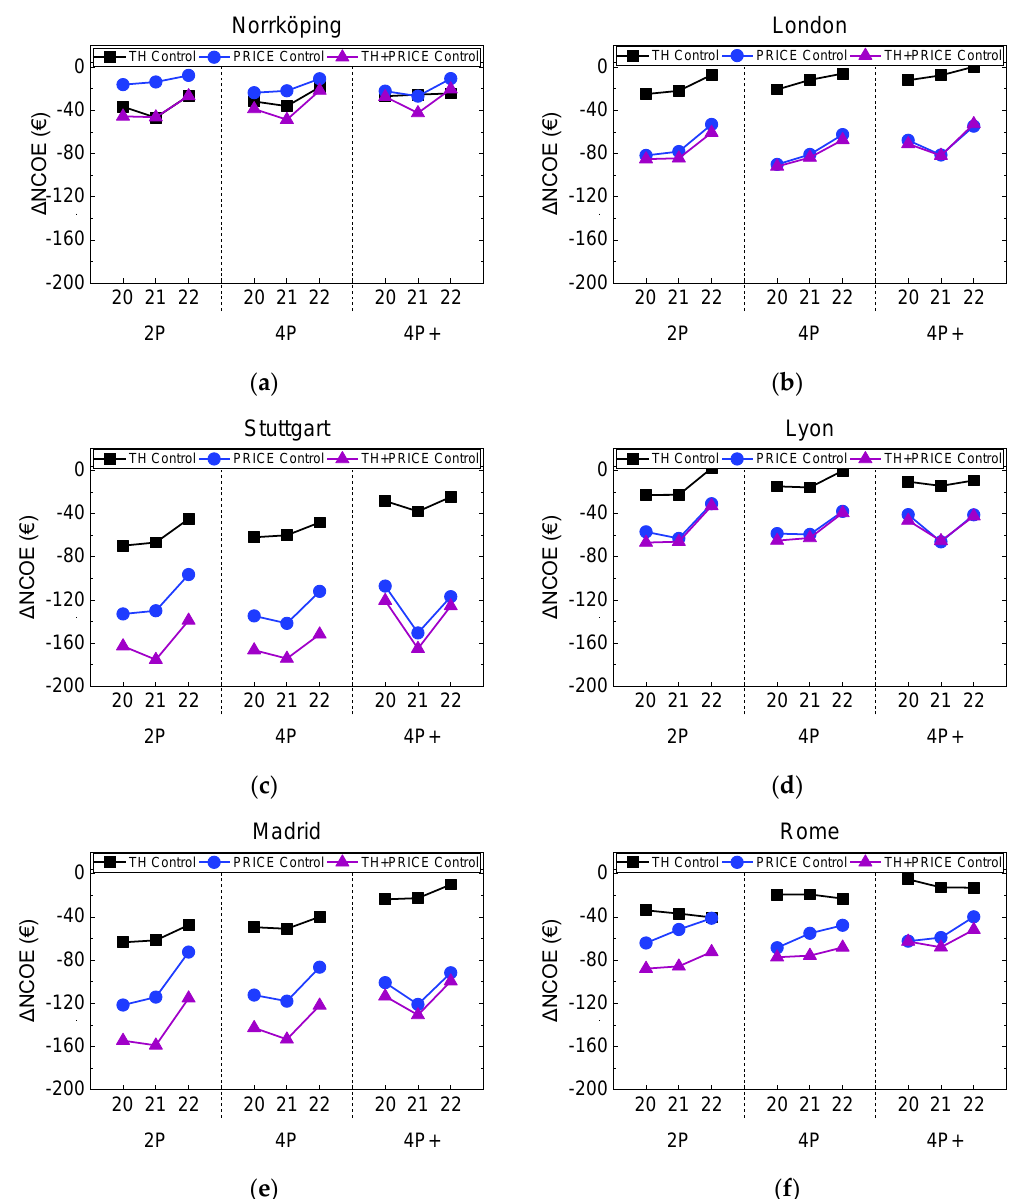
Figure 10. Change of net annual cost of electricity (ΔNCOE) due to the advanced control algorithms for the small PV system with battery for the full range of boundary conditions: country, appliance use (2P, 4P, and 4P+) and room set temperature (20, 21, and 22 °C). ( a )–( f ) shows the ΔNCOE respectively for each of the six examined locations.